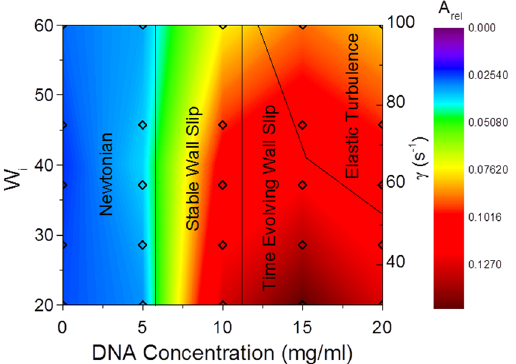
Figure 3. Phase diagram of the different types of flow for high salt DNA solutions as a function of the Weissenberg number (proportional to the applied shear rate ( γ  ) and the concentration of the DNA). The colour map shows values of the integrated area of each velocity profile as a function of depth, subtracted from the constant gradient expected for Newtonian-like flows ( A rel ), measured at the points indicated by hollow diamonds. The boundaries between the different flow regimes are also shown. The shear rates have been rescaled to give the Weissenberg number ( W I ) to facilitate comparison between